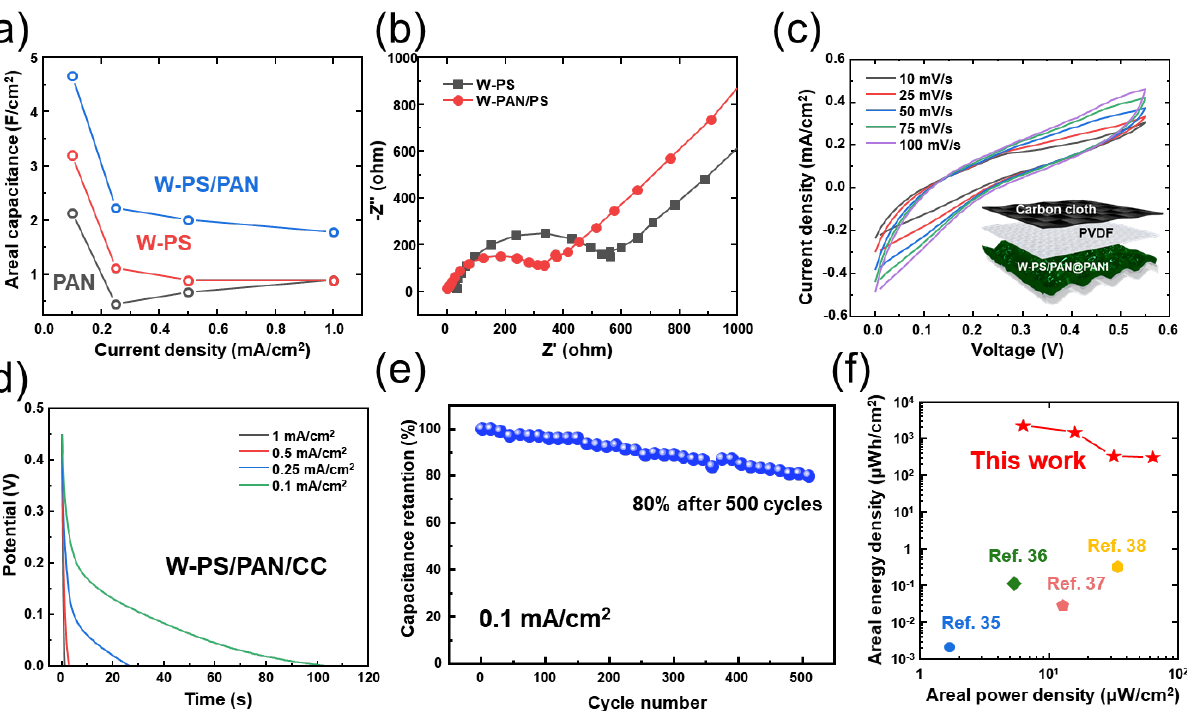
Figure 4. ( a ) Areal capacitance of PAN, W-PS, and W-PS/PAN. ( b ) Nyquist curves of W-PS and W-PS/PAN. ( c ) CV curves measured at varied scan rates from 10 to 100 mV/s, and ( d ) GCD curves measured at varied current densities from 0.1 to 1 mA/cm 2 . (inset) Schematic diagram of hybrid supercapacitor (HSC). ( e ) Cycling stability of W-PS/PAN at a current density of 0.1 mA/cm 2 . ( f ) The areal energy and power density of W-PS/PAN/CC supercapacitor compared with those of previously published